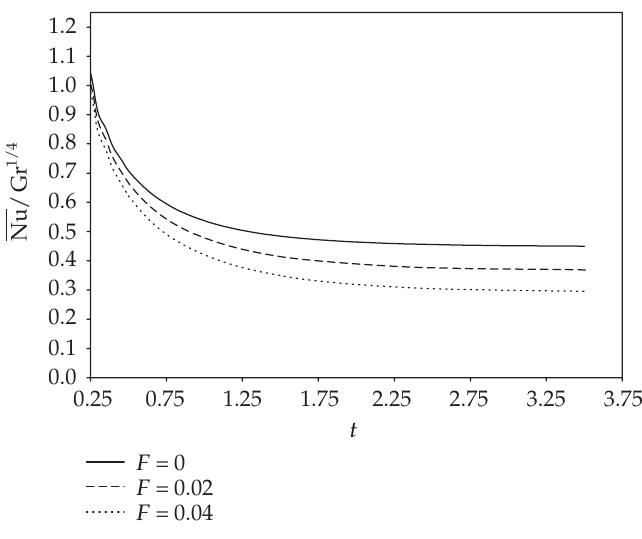
Figure 5.14 . The e ff ect of radiation parameter on average Nusselt number at M = 1, m = 1, and Pr = 0 . 7.